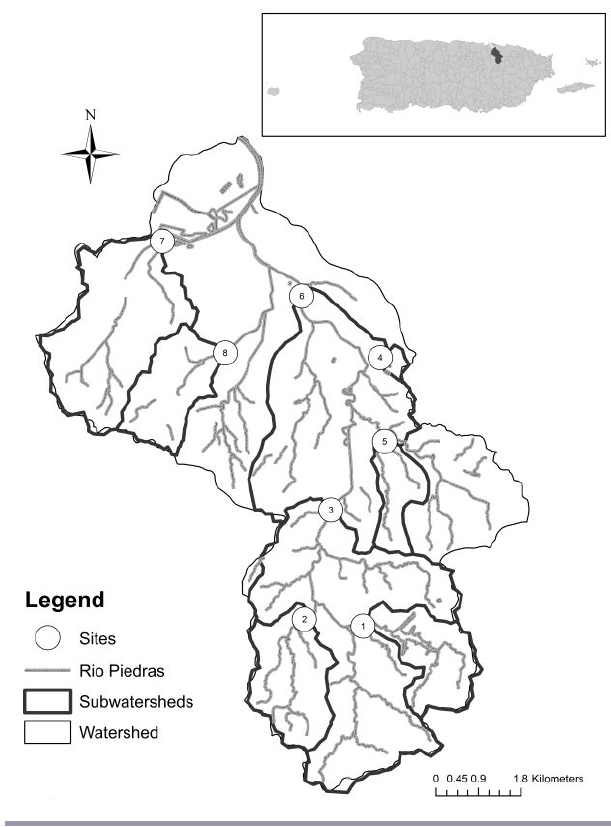
bodies to calculate areal extents and impervious surface percentages for each subwatershed. Fig. 1 . Map of the Río Piedras Watershed and Puerto Rico. The study subwatersheds are delimited based on a 30 m digital elevation model. Site numbers as in Table